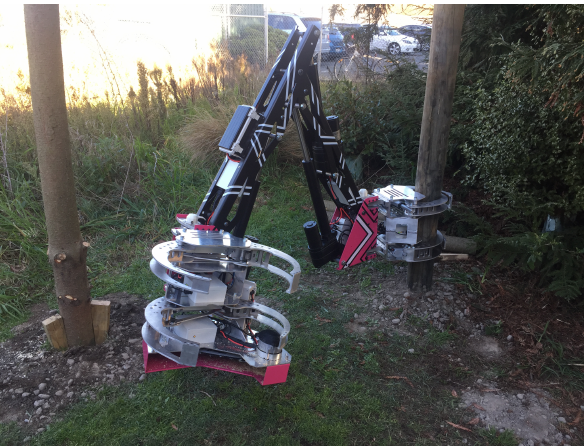
Figure 3. Tree to tree robot (image taken by SCION NZ Forest Research Institute, used with permission from Richard